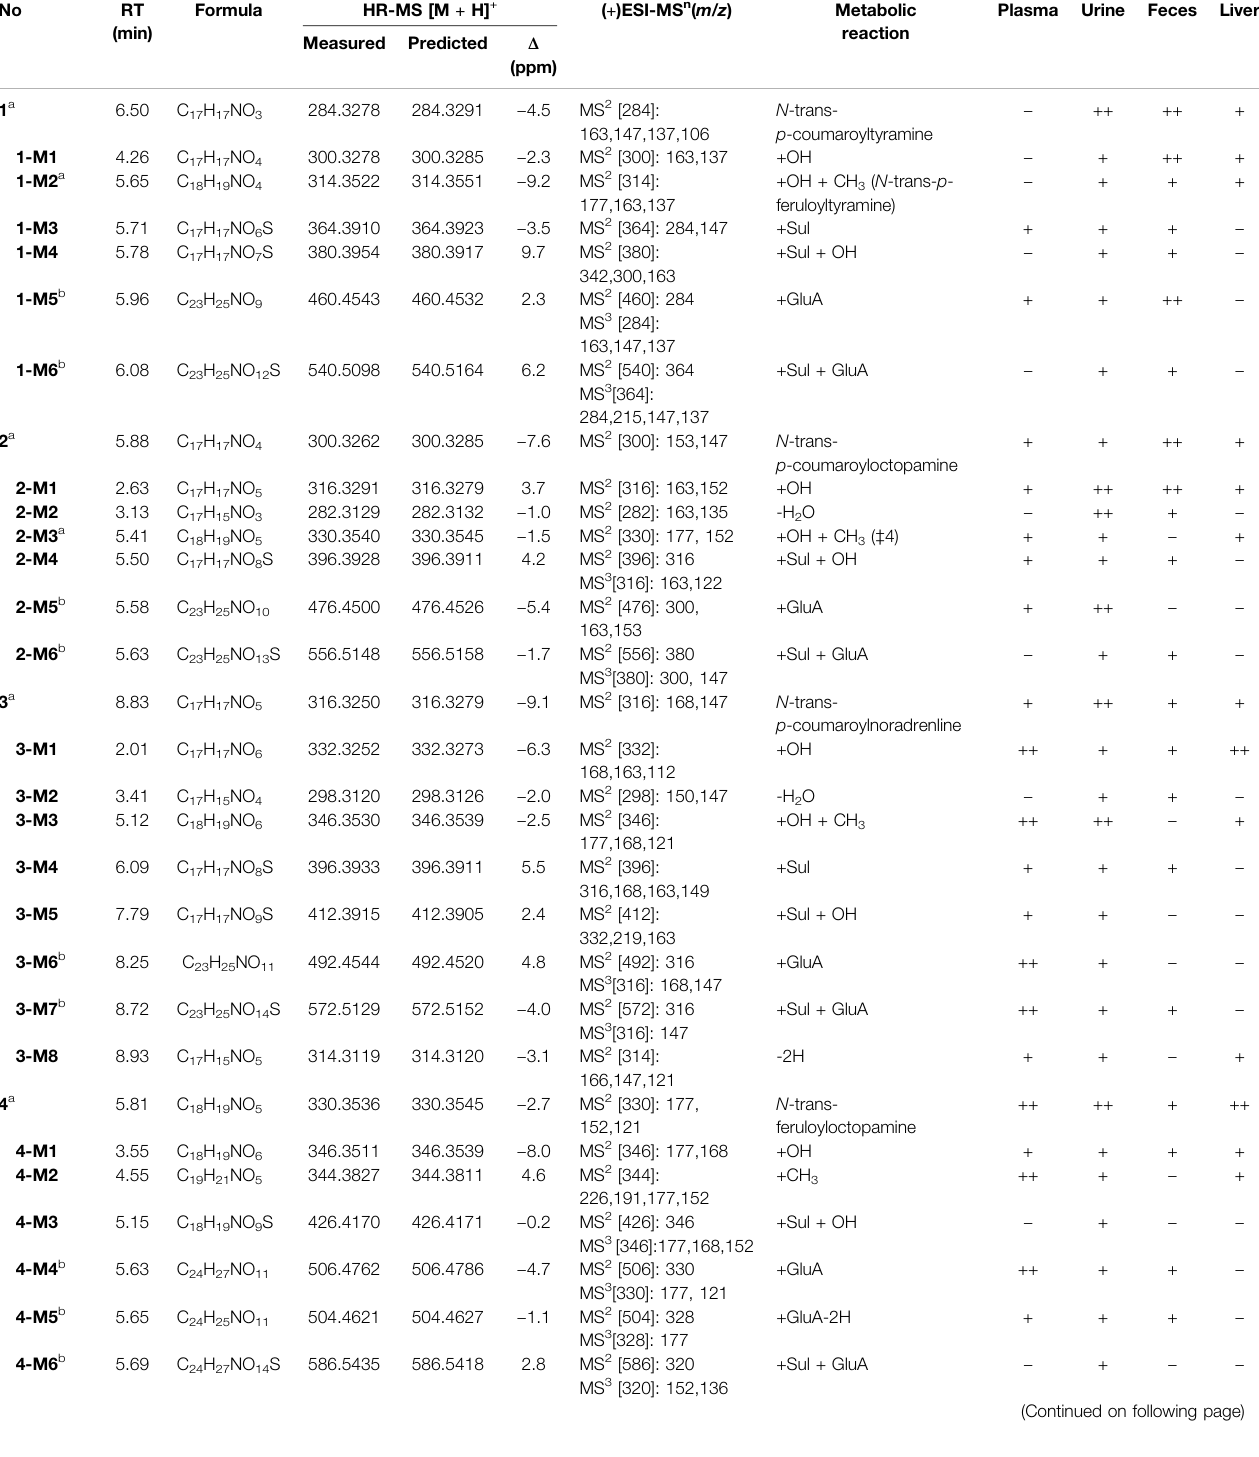
TABLE 1 | Characterization of in vivo metabolites of eggplant green calyx compounds 1 – 5 by